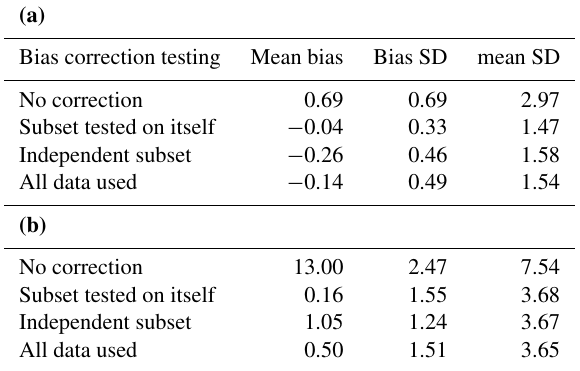
Table A3. (a) Bias correction robustness test for LMT observations over ocean. Comparisons to aircraft data are tested using (1) no bias correction, (2) bias correction using the test dataset, (3) an indepen- dent dataset, and (4) the entire dataset. (b) Bias correction robust- ness test for LMT observations over land. Same as Table A3a but for land.